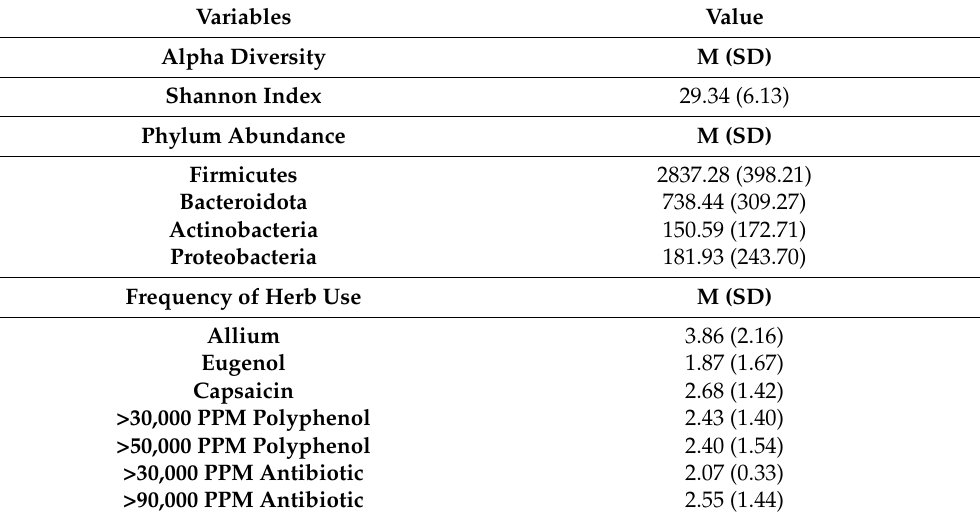
Table 1. Characteristics of exposure and outcome variables ( n =